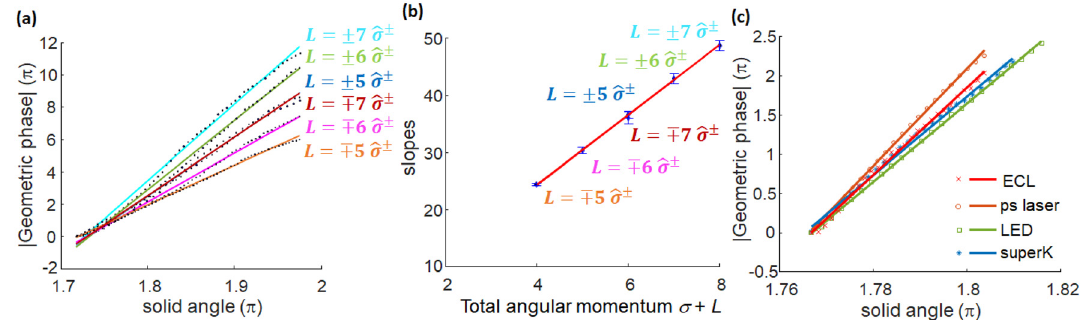
Figure 7: (a) Geometric phaseversus fiber path solid angle for sixdistinctpairs of orbital angularmomentum(OAM)modes.The colored lines are linear fits of the experimental data (black solid circles). All modes show a clear linear relationship; (b) The slope of each trace (for each mode)shownin(a)versustheTAM= L + σ oftherespectivemodes.The highdegreeoflinearityaswellas theslopeofthislinematchwellwith theory that accounts only for geometric effects; (c) Geometric phase versus solid angle for two degenerate OAM modes L (cid:1) ± 7 (cid:6) σ ± (as shown earlier in (a)), using multiple light sources. External cavity laser (ECL) is a narrow linewidth (100 kHz) source at 1550 nm; ps laser is a picosecondlaserat 1550nmwith ∼ 0.5nmbandwidth;theLEDhasabandwidth ∼ 35nmaround1525nm;superKrepresentsasupercontinuum source with 3 dB bandwidth up to ∼ 250 nm at around 1475 nm. Similar slopes for all these sources demonstrates weak dependence of wavelength on geometric